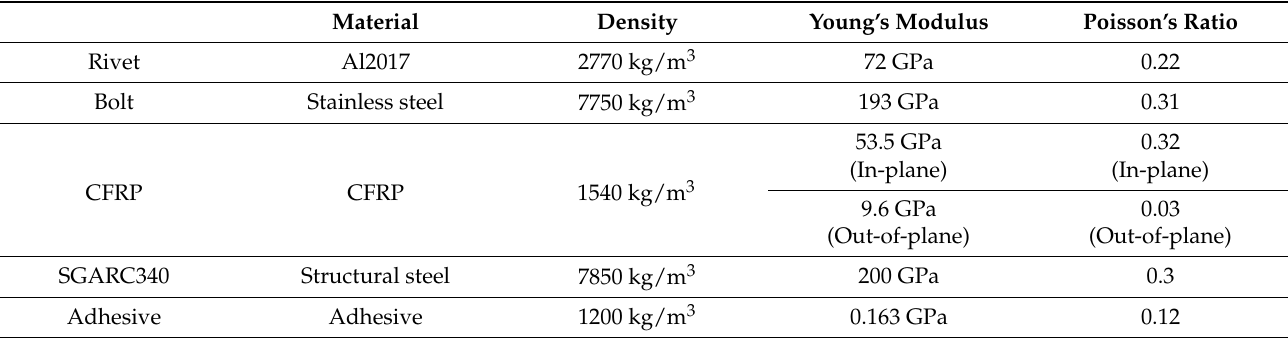
Table 2. Material parameters used for numerical